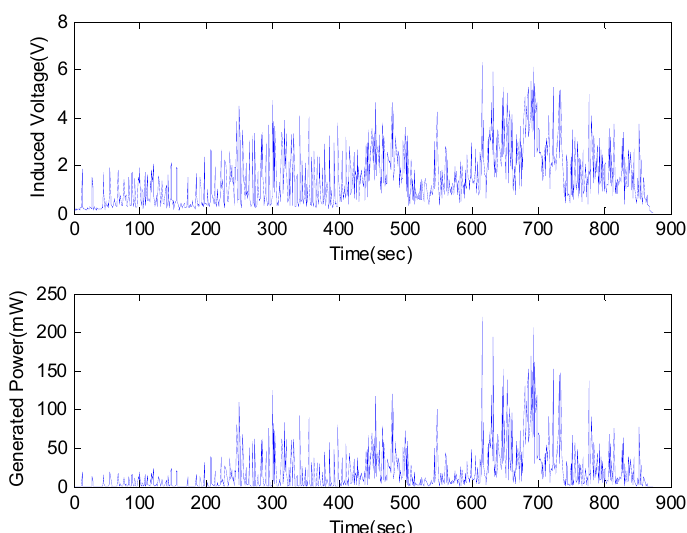
Figure 7. The root mean square (forward, RMS) generated voltage with a 360 Ω load resistance (V rms-veh-T ) (y-axis) ( top ) and the experimentally generated power (P exp-veh-T ) (y-axis) ( bottom ) by every 1-s time interval of the VEH device on the high-speed train at one lower coil before the spring damage in the high-speed train test was about 900 s: the RMS V rms-veh-T was 1.87 V and the P exp-veh-T was 9.71 mW (one lower